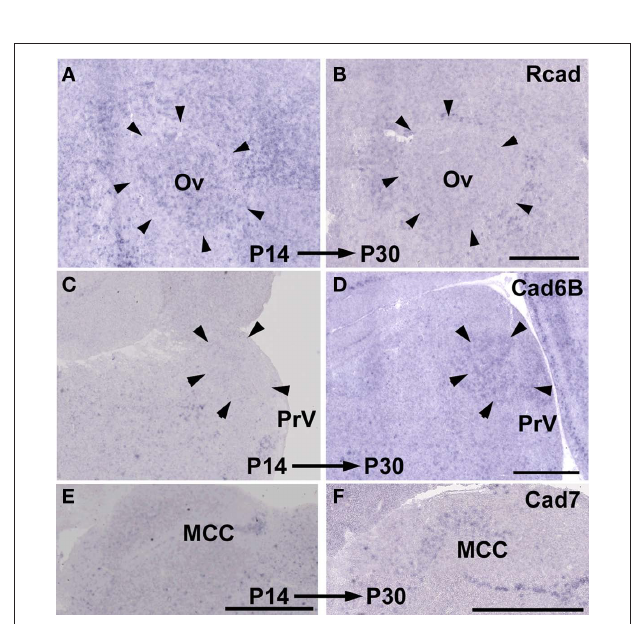
Figure 11 | Developmental difference in cadherin expressions between P14 and P30. Rcad expression in Ov of Bengalese finch (A,B) . Cad6B expression in PrV of budgerigar (C,D) . Cad7 expression in MCC of quail (e,F) . Scale bars are 1 mm.